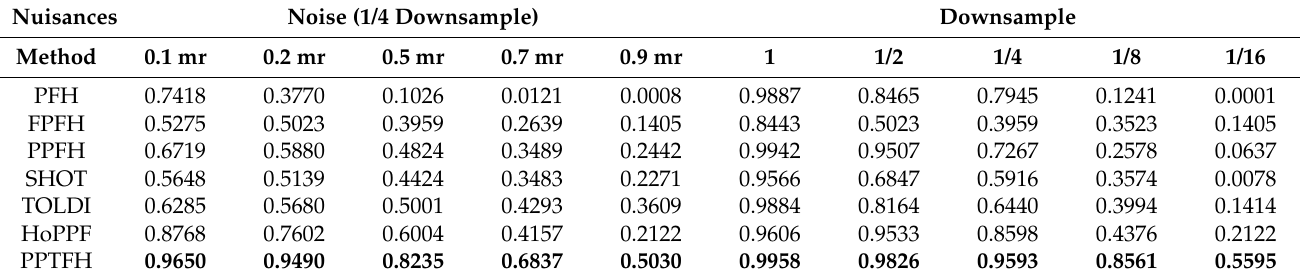
Table 3. Robustness (AUC pr ) to different nuisances in Bologna dataset.